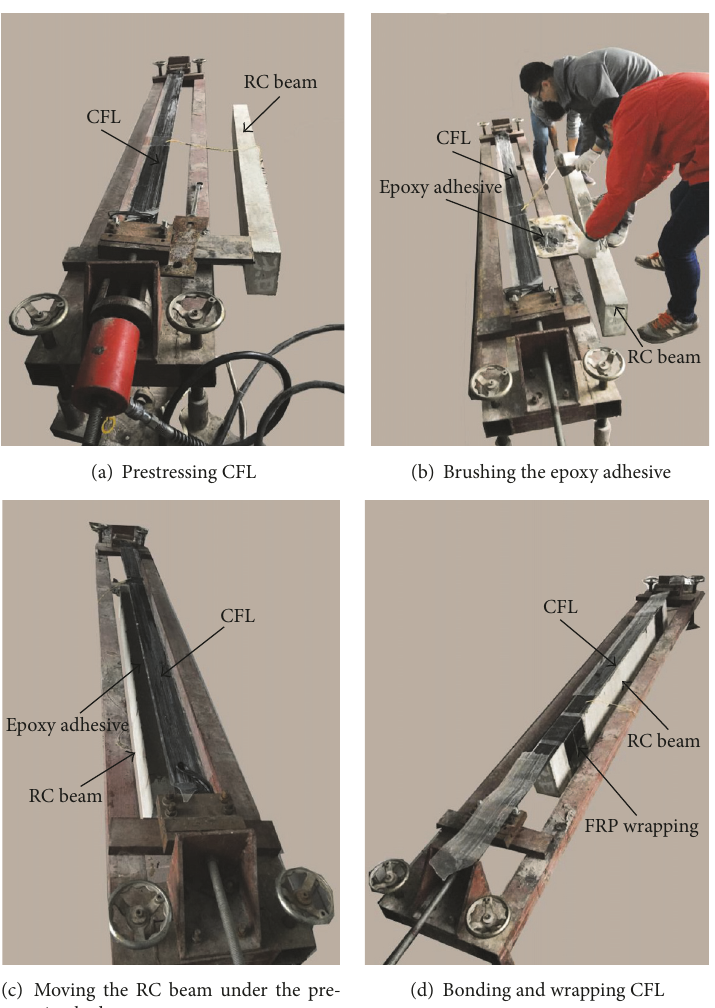
Figure 4: Strengthening method with prestressed CFL for RC beams.